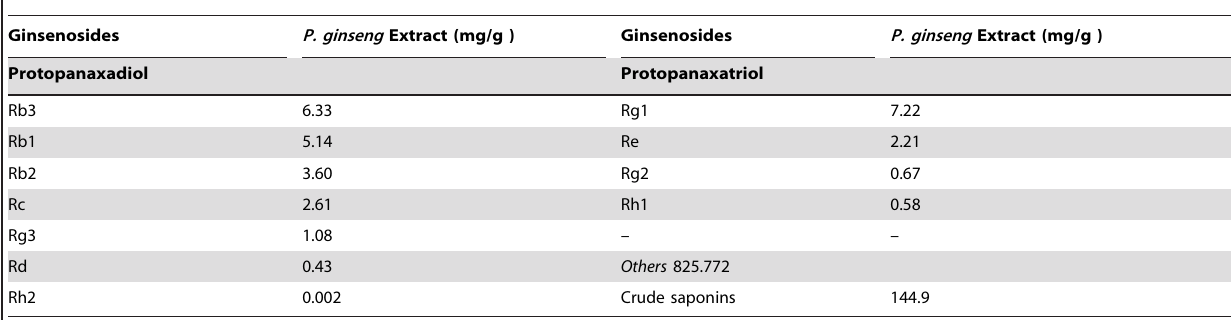
Table 2. Compositional analysis of P. ginseng by